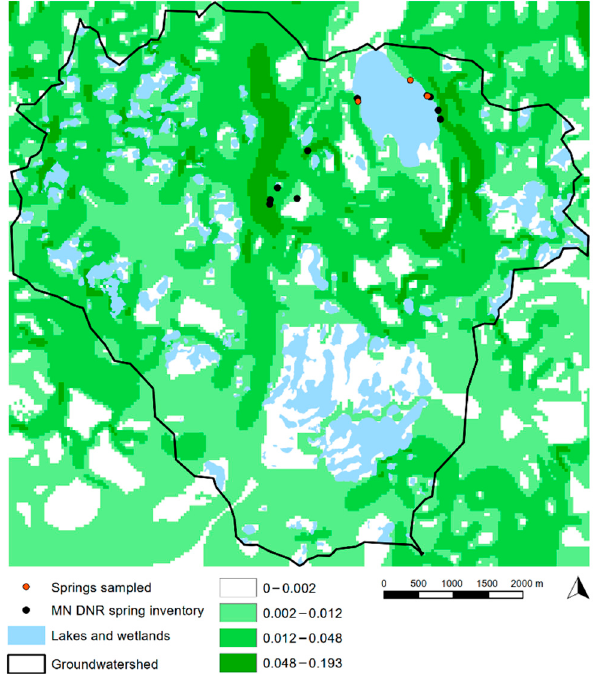
Figure 7. Modeled hydraulic gradient within the study area. Springs sampled for this report are shown in red and those reported in the Minnesota Spring Inventory (Minnesota Department of Natural Resources 2019b) [57] are shown in black.